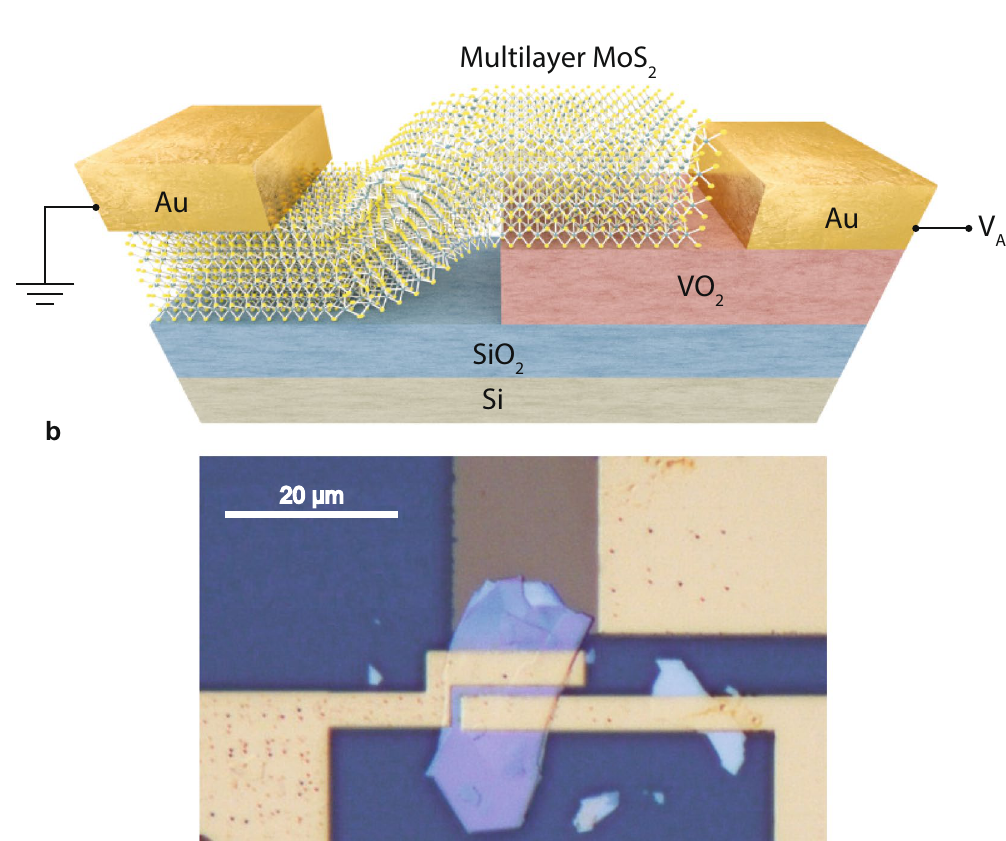
Figure 1. VdW MoS 2 /VO 2 heterojunction schematic. ( a ) Three-dimensional schematic view of the MoS 2 / VO 2 heterojunction with the bias configuration used in the experiments. The MoS 2 contact is grounded while the bias is applied and swept on the metal contact on VO 2 . ( b ), Optical image of the fabricated heterojunction composed of a multilayer MoS 2 flake and VO 2 pre-patterned structure. Gold contacts to the two sides of the junction have been deposited to characterize the device. Two distinct set of contacts were deposited on the MoS 2 flakes to verify their electrical